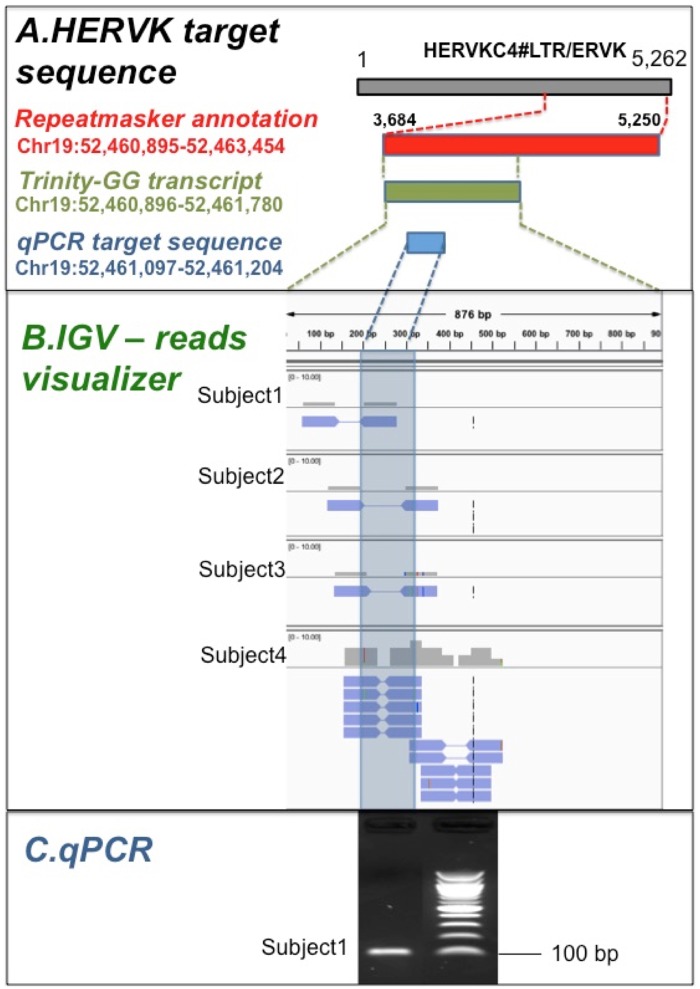
Validation of the actively transcribed HERV locus HERVKC4 on chromosome 19 in human DLPFC. A (top figure). The cartoon reports the sequence coordinates (not in scale) of the tested HERVKC4 (in red), the transcript assembled by GGDNA (in green) and the region captured by qPCR (in blue). B (middle figure). Visualization of the read alignment to the GGDNA transcript for each of the four RNA samples; highlighted in blue the region corresponding to the qPCR product. C (bottom figure). Result on agarose gel of the qPCR product for one RNA sample with the relative length size of 100 bp. Quantitative RT-PCR (qRT-PCR) validation experiments of four HERVKC4 transcripts were carried-out on four of the nineteen analyzed RNAs extracted from the human DLPFC samples (three controls and one Schizophrenia sample). The sequence identity of the purified PCR products has been confirmed by direct sequencing.